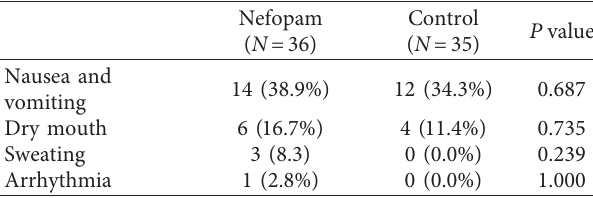
Table 4: Adverse effects of nefopam and control